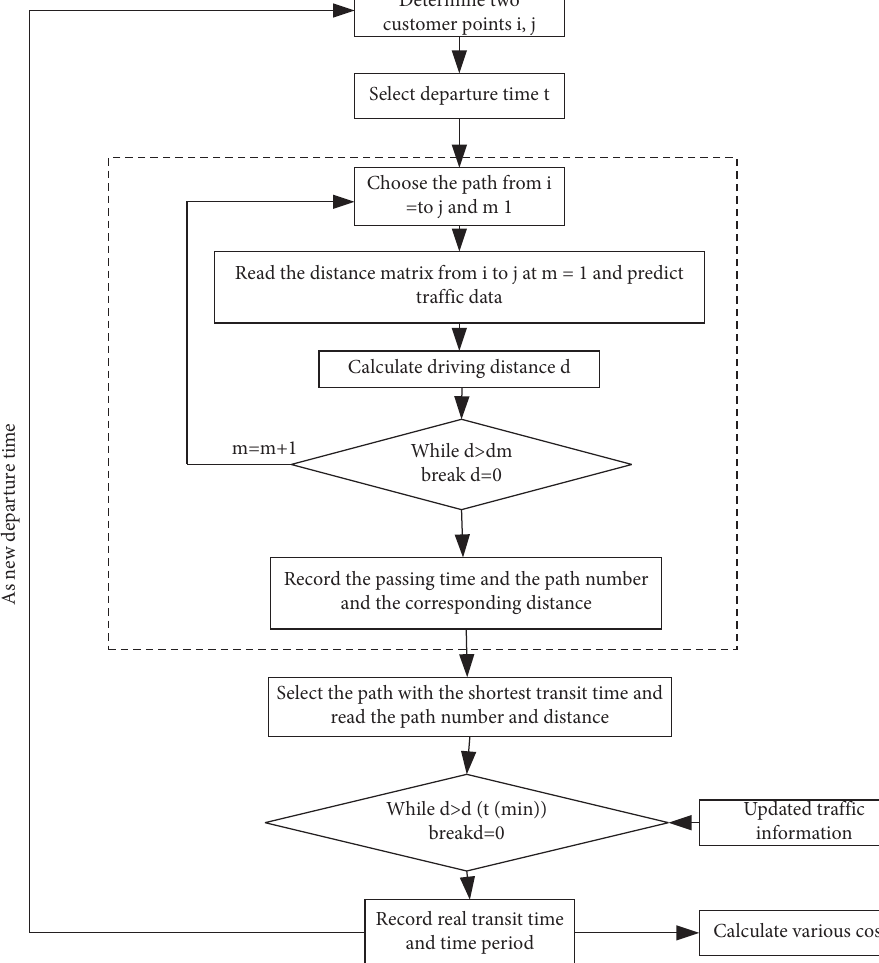
Figure 12: Double-loop objective function solution. Table 1: Data in the